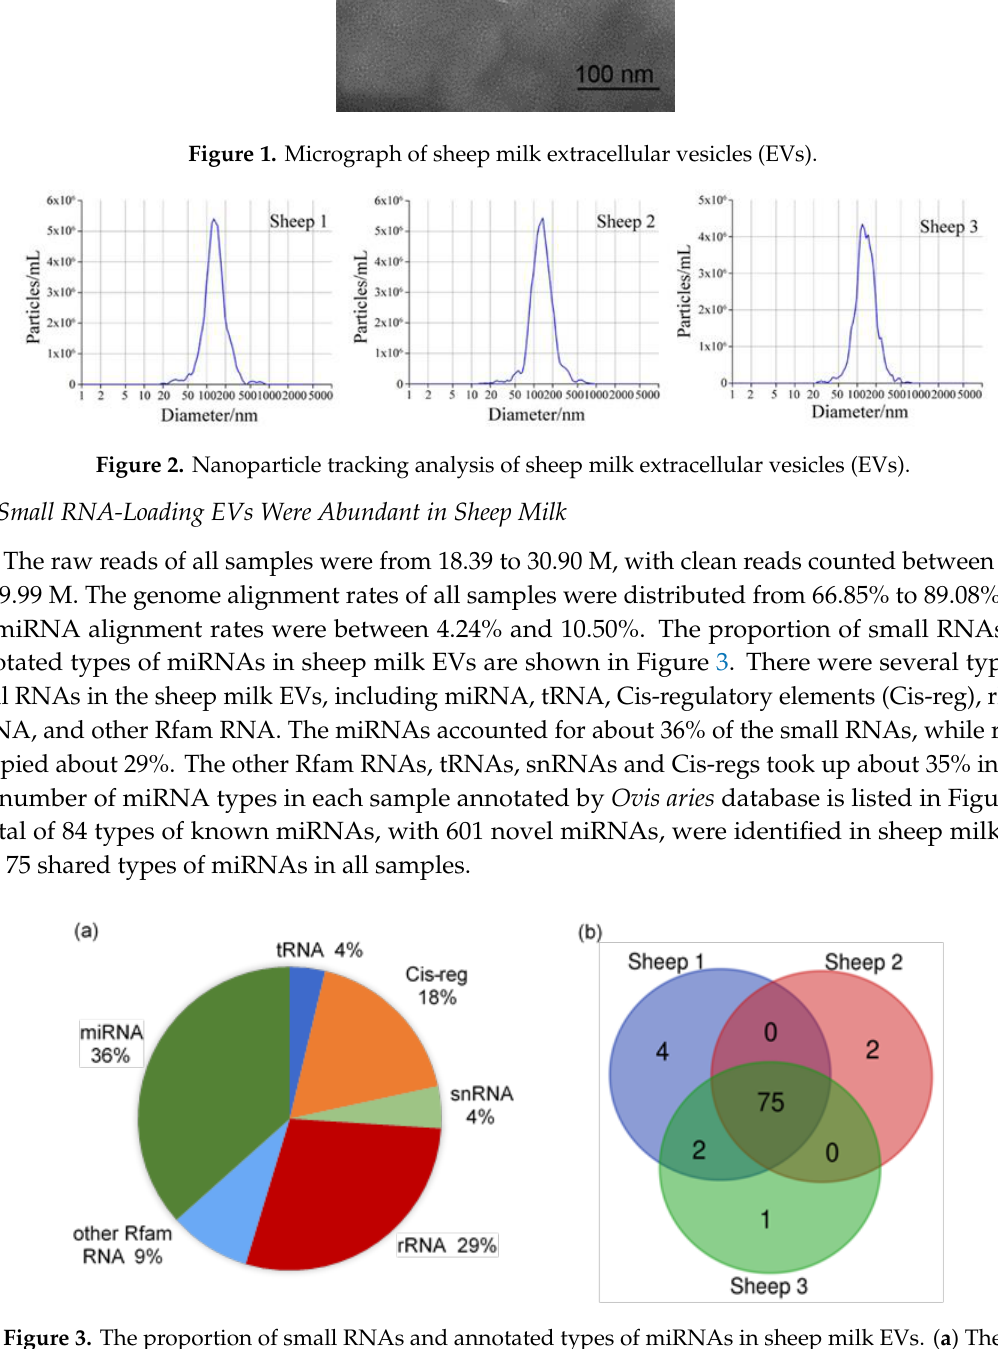
Figure 3. The proportion of small RNAs and annotated types of miRNAs in sheep milk EVs. ( a ) The proportion of small RNAs in sheep milk EVs. ( b ) The annotated types of miRNAs in sheep milk EVs.